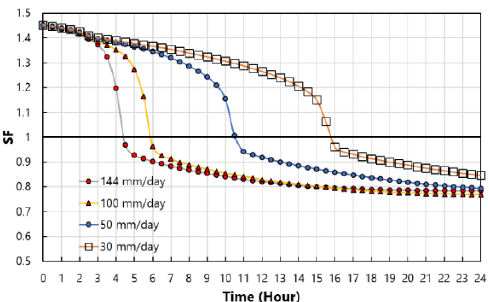
Figure 17. Change in safety factor with time under different flux.